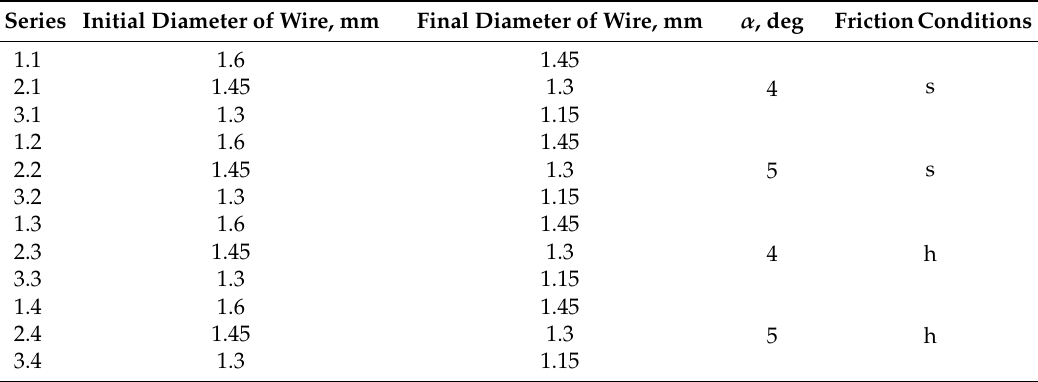
Table 2. Plan of the